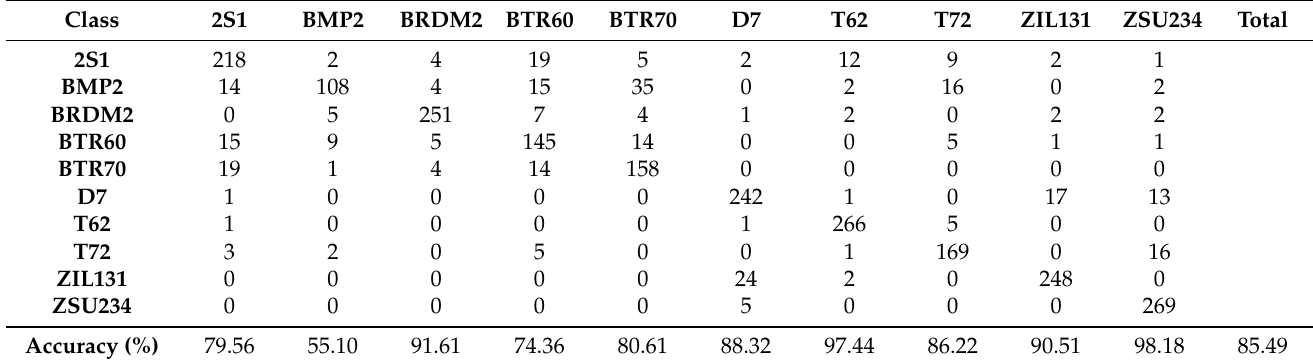
Table 2. Confusion matrix of classification accuracy based on the CDA and sparse SAR image via 20 samples per class.